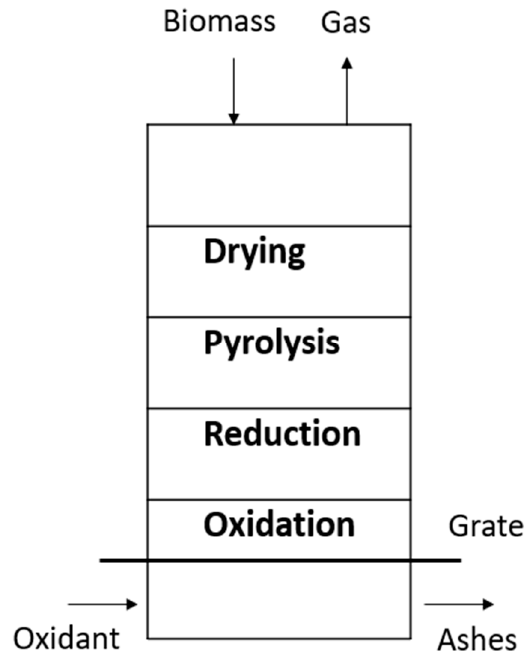
Figure 1. Fixed bed updraft gasifier.